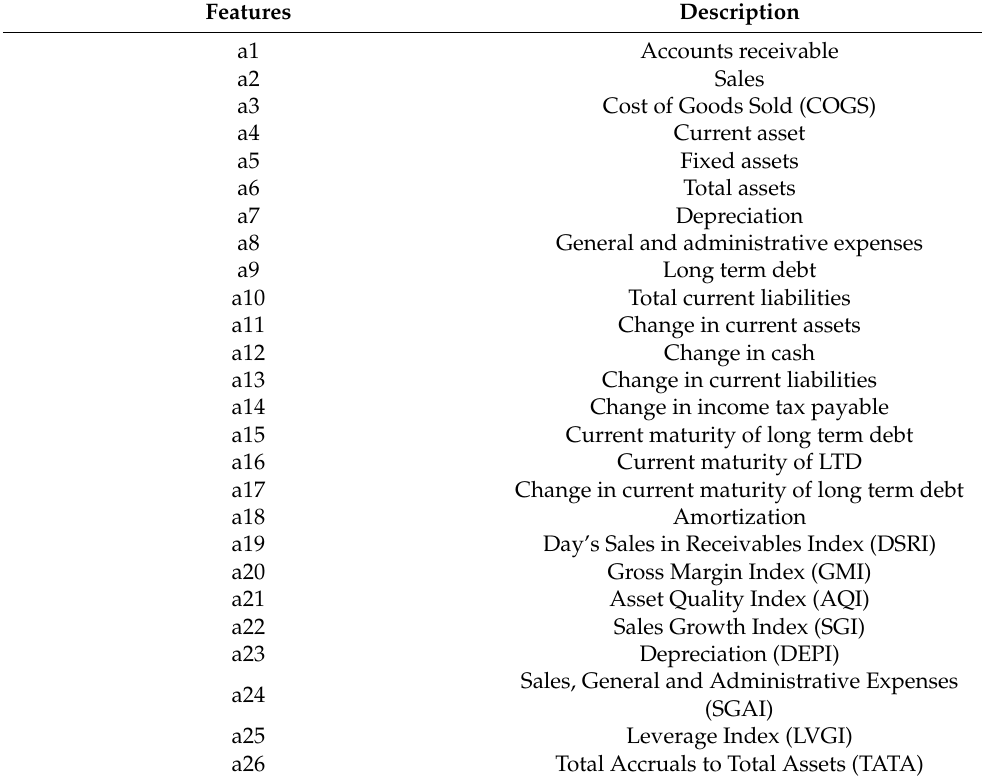
Table 2. Financial